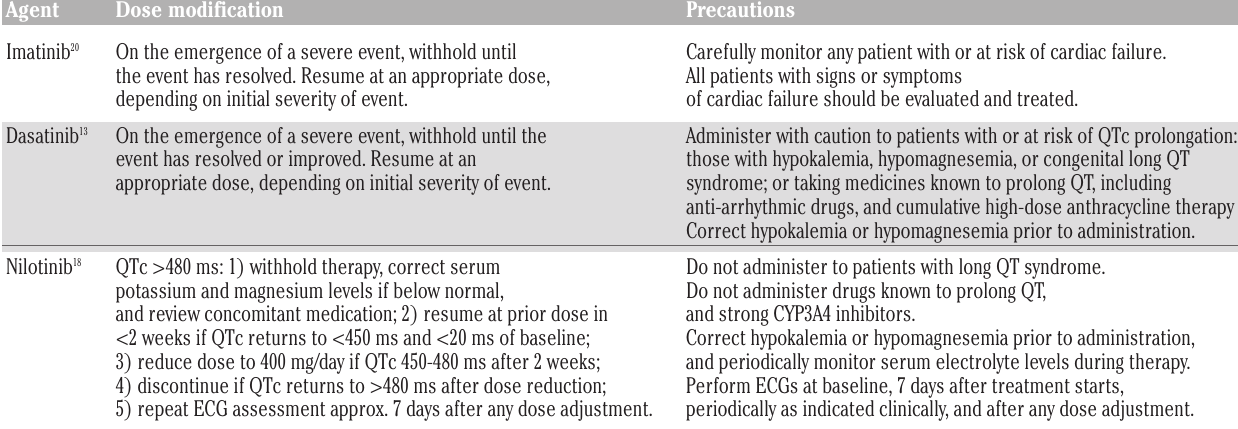
Table 2. Precautions and dose modifications on the emergence of cardiac events during tyrosine kinase inhibitors treatment.